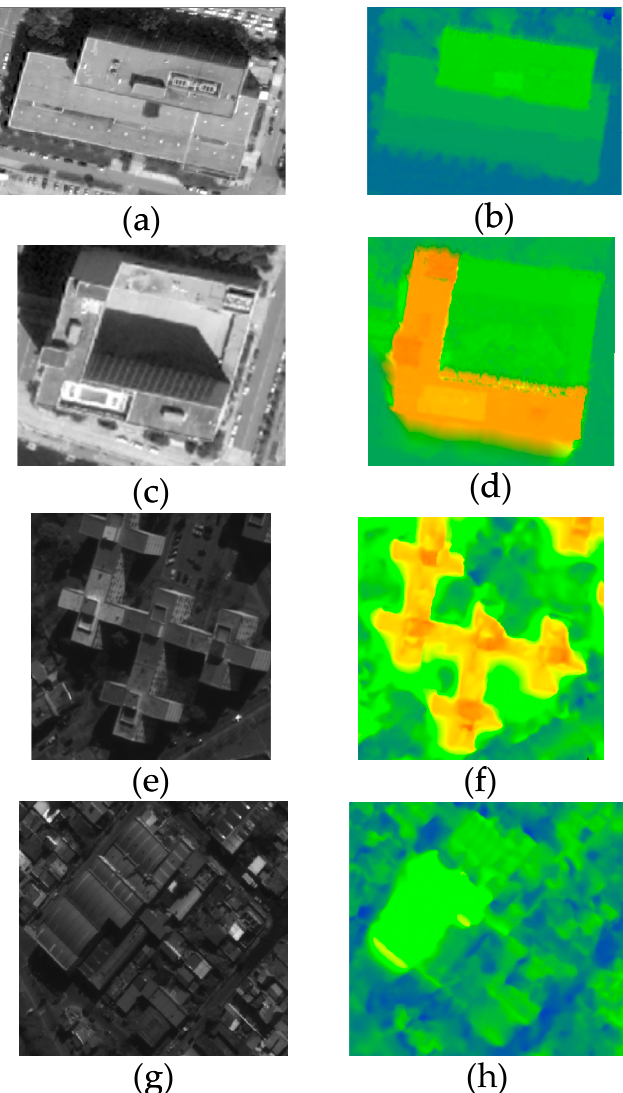
Figure 13. Results for test site 1 with different methods: ( a ) input, ( b ) refinement, ( c ) SGM, ( d ) PCI.